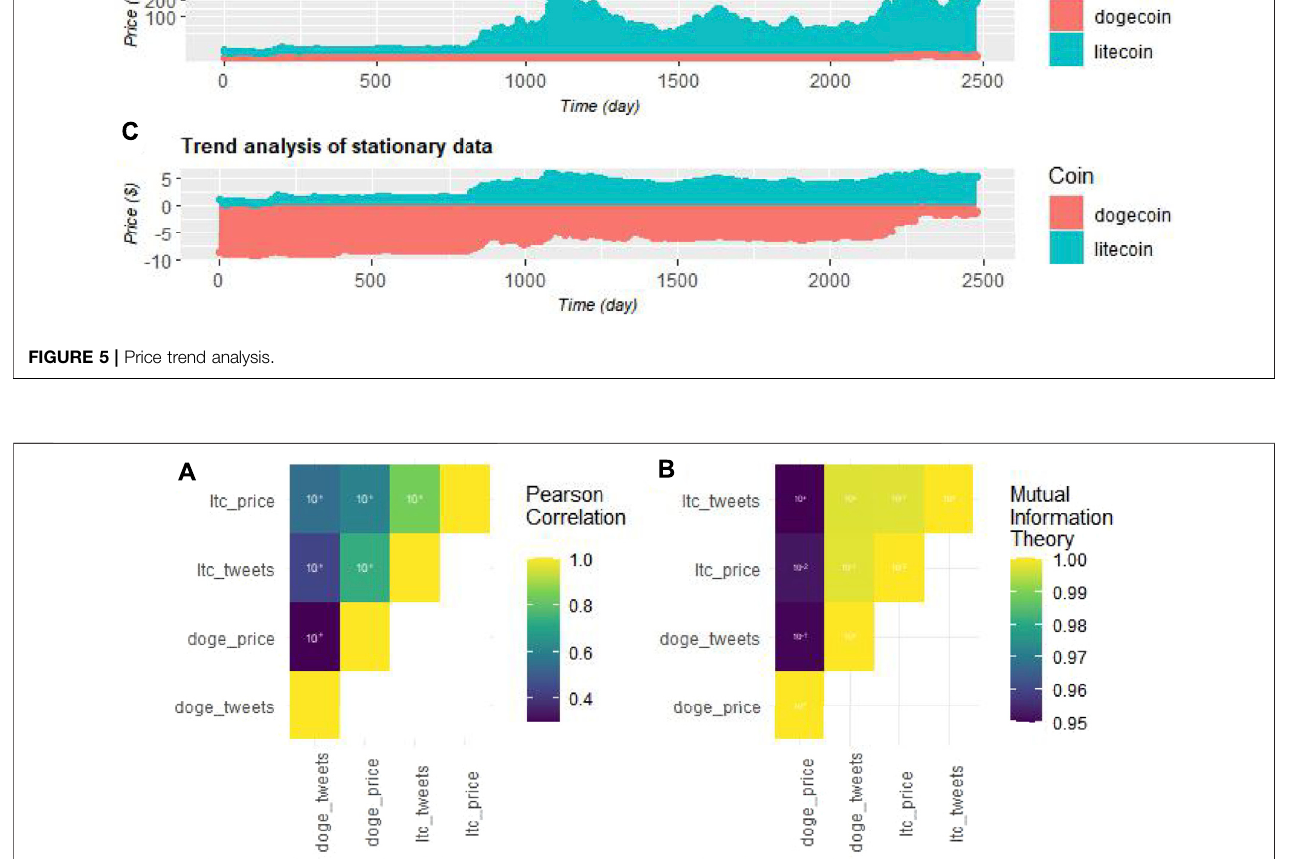
Frontiers in Blockchain |